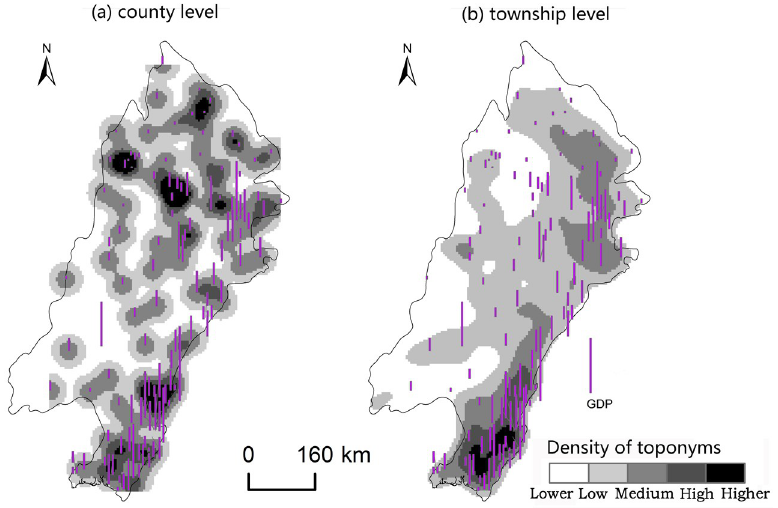
Fig 9. Spatial distribution of toponym density and county GDP of the Northeast China Plain. The statistical data on China’s GDP in 2010 (Figs 8, 10, 12) were obtained from the RESDC.